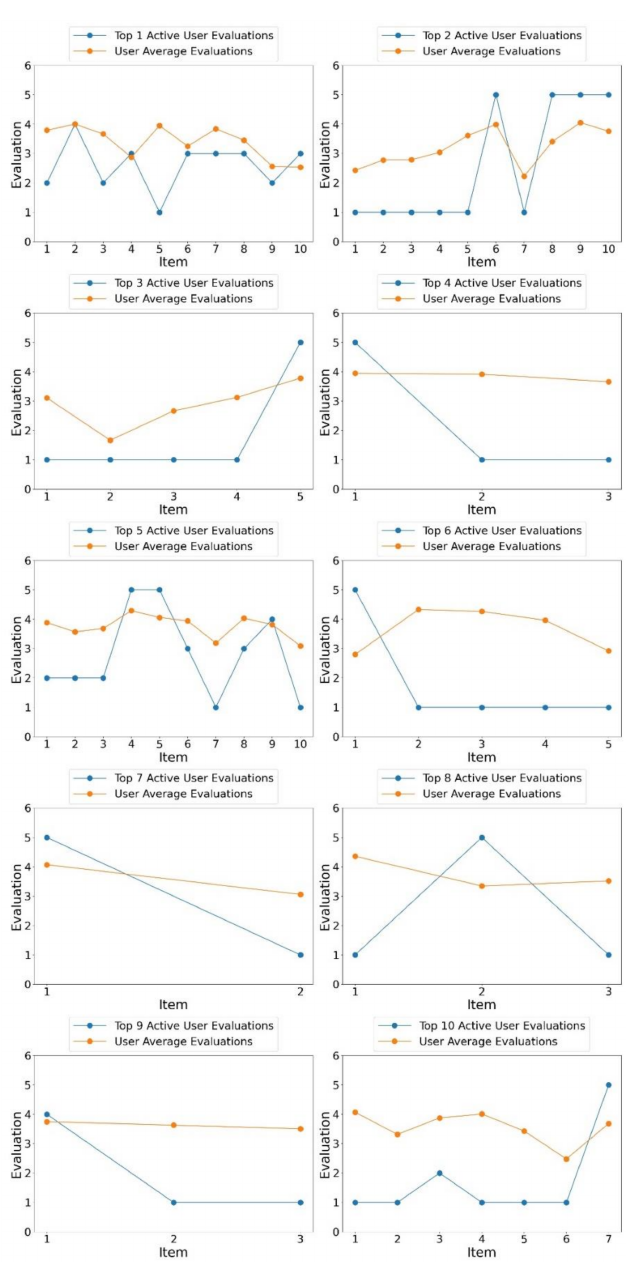
Figure 10. Comparison of the evaluations by the top 10 active users with the average evaluations by all